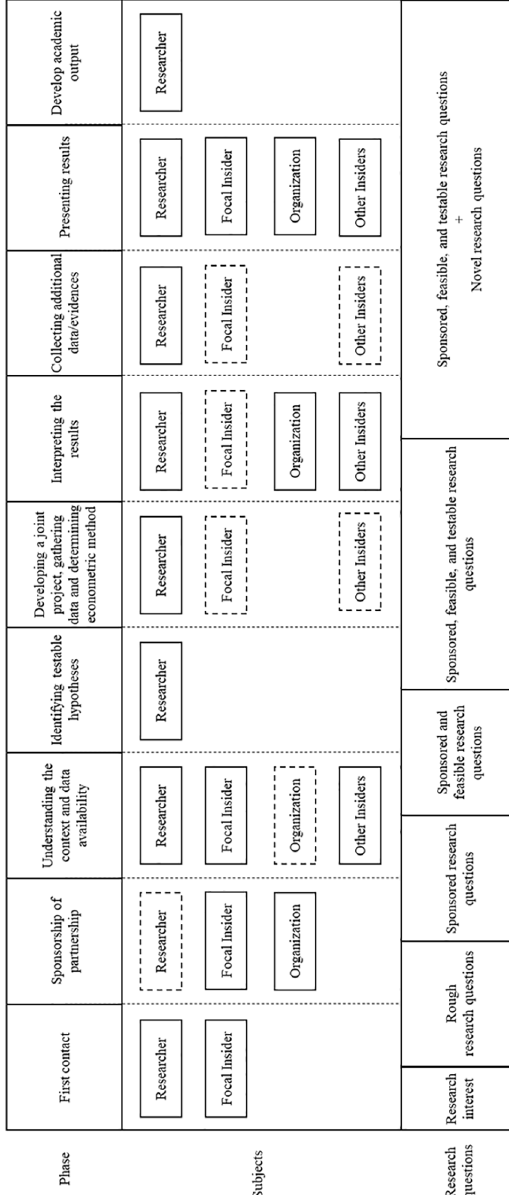
Figure 1. Phases of an